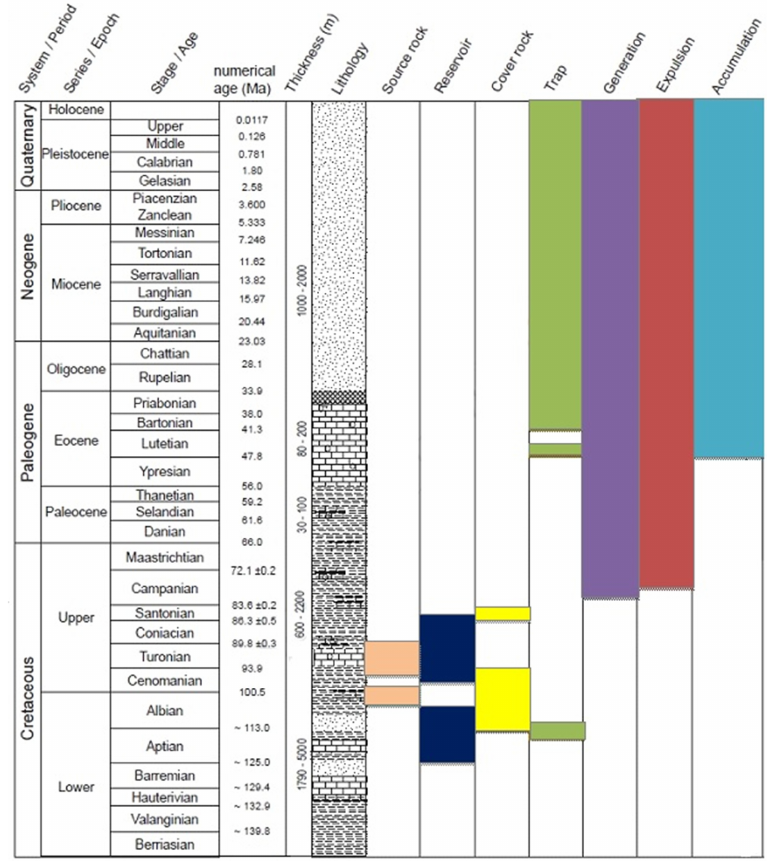
Figure 2. Lithostratigraphic column and the total petroleum system of the southeast Constantine Basin in northern Algeria (for details, please refer to Bentaalla ‐ Kaced et al. [11] and Boutaleb et al.